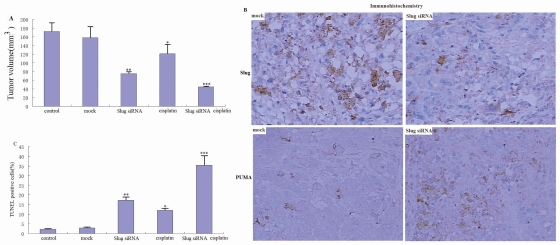
Slug silencing sensitizes cholangiocarcinoma xenograft tumors to cisplatin. A, growth bar of QBC939 tumors (n = 6 per group) subjected to Slug siRNA, mock, and PBS and/or combined with cisplatin treatment for 28 days. B, Immunohistochemistry analysis for Slug and PUMA in different groups. C, TUNEL-positive cells in three groups were detected in the control, cisplatin, or Slug siRNA plus cisplatin treatments. Columns and bars represent the mean of three independent determinations and S.D., respectively. *P < 0.05, **P < 0.01, ***P < 0.01.